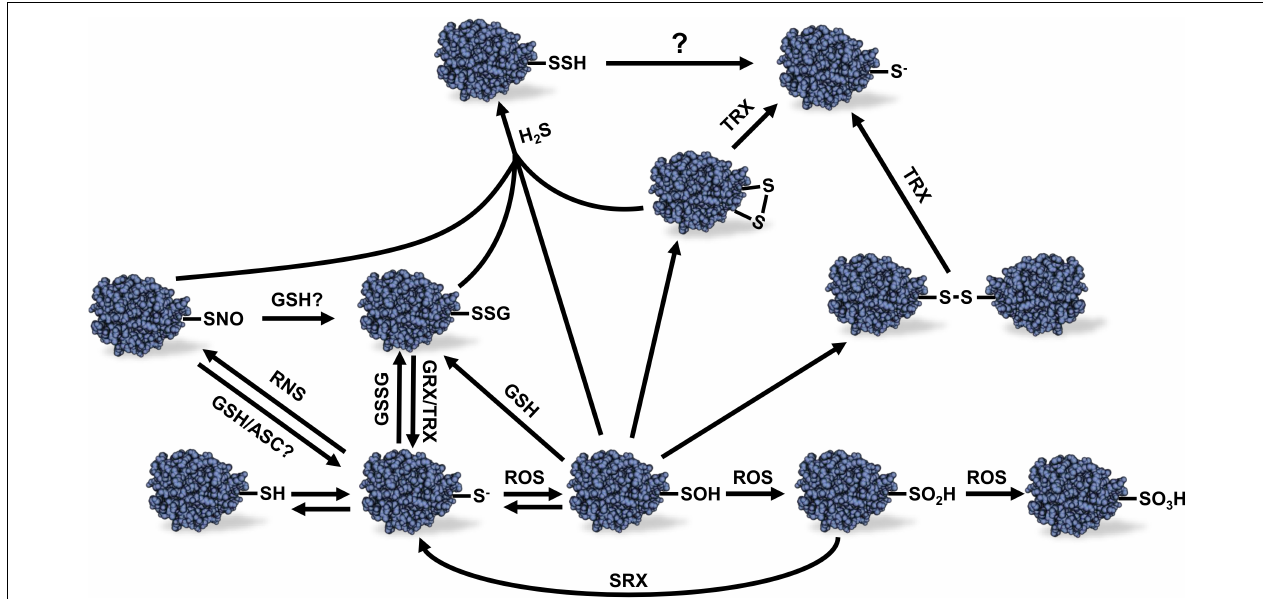
FIGURE 1 | Different redox modifications of protein Cys thiols and their reversibility. Protein thiol oxidation can lead to a variety of redox modifications. The scheme presents the relations between the different redox modifications and the reversibility of these modifications. Sulfonic acid (–SO 3 H) formation is considered to be irreversible as well as sulfinic acid (–SO 2 H) except in the case of certain peroxiredoxins which sulfinic acid Cys residue can be reduced by sulfiredoxin using and ATP-dependent mechanism. See text for details. ROS, reactive oxygen species; RNS, reactive nitrogen species; H 2 S, hydrogen sulfide; GSSG, oxidized glutathione; GSH, reduced glutathione; ASC, ascorbate; GRX, glutaredoxin; TRX, thioredoxin; SRX, sulfiredoxin; R-SH, reduced thiol; R-S − , thiolate anion; R-SOH, sulfenic acid; R-SNO, protein S- nitrosylation; R-SSG, protein S -glutathionylation Cys; R-SSH, protein S -sulfhydration; R-SS-R, disulfide